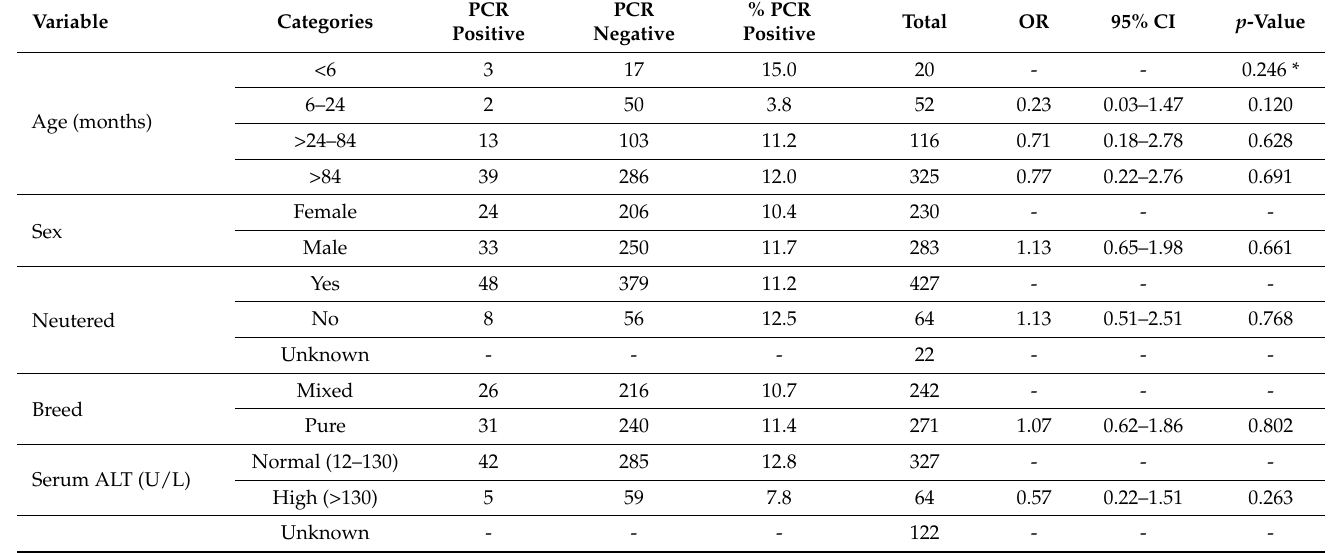
Table 2. Univariable associations between domestic cat hepadnavirus DNA PCR result and indepen- dent variables in owned cats from Hong Kong using simple logistic regression.